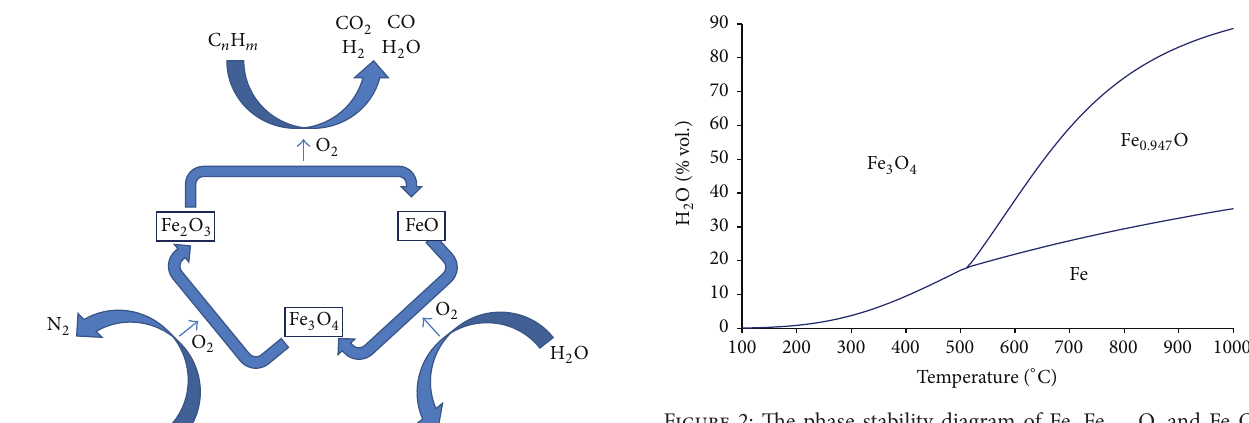
Figure 2: The phase stability diagram of Fe, Fe 0.947 O, and Fe 3 O 4 phases in H 2 O-H 2